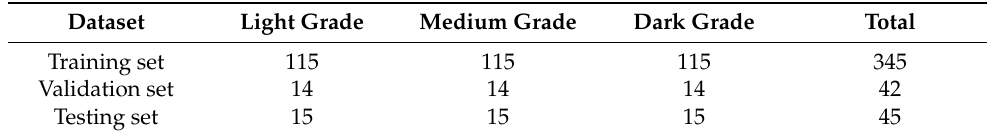
Table 1. Experimental data segmentation of three color grades.